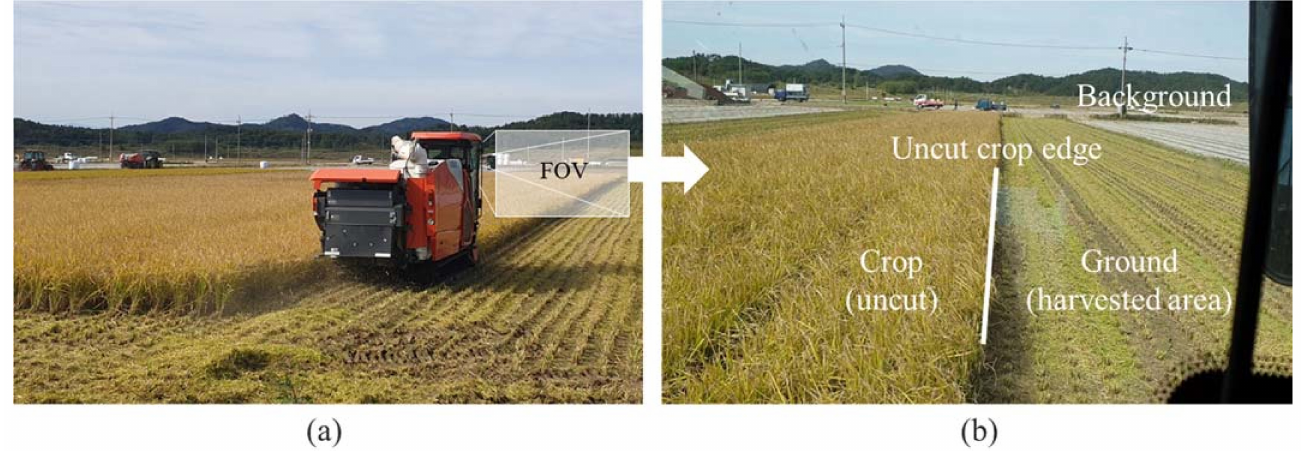
Figure 1. Harvesting scene of a combine harvester in a rice paddy ( a ) and a representative sample image including the operator’s field of view ( b